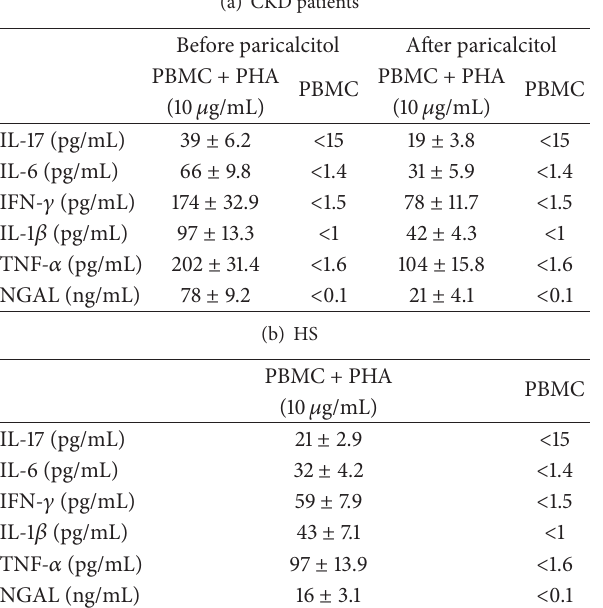
Table 2: Production in vitro of NGAL and inflammatory cytokines. Table 3: Univariate and multiple regression analysis of NGAL in CKD